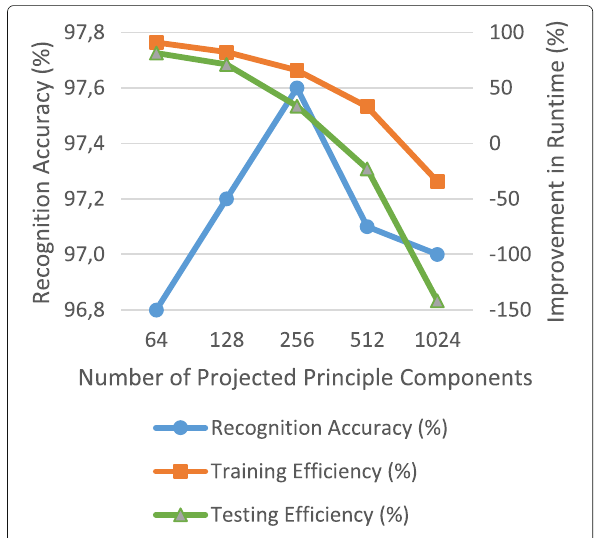
Fig. 12 The effect of varying the number of projected principle components on recognition accuracy and runtime for seven classes of emotion in the CK+ dataset